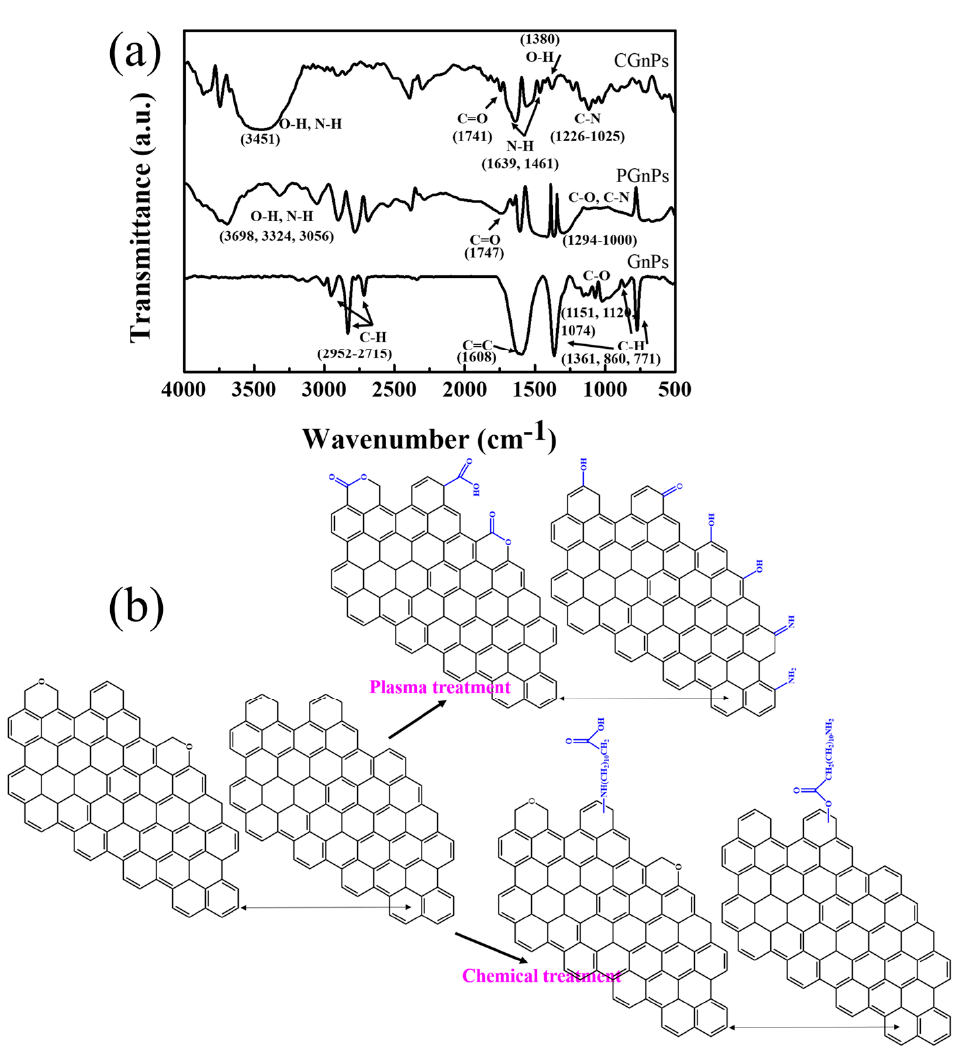
Figure 2. ( a ) FTIR spectra of pristine GnPs, PGnPs and CGnPs; ( b ) structure of pristine GnPs before and after surface modification.